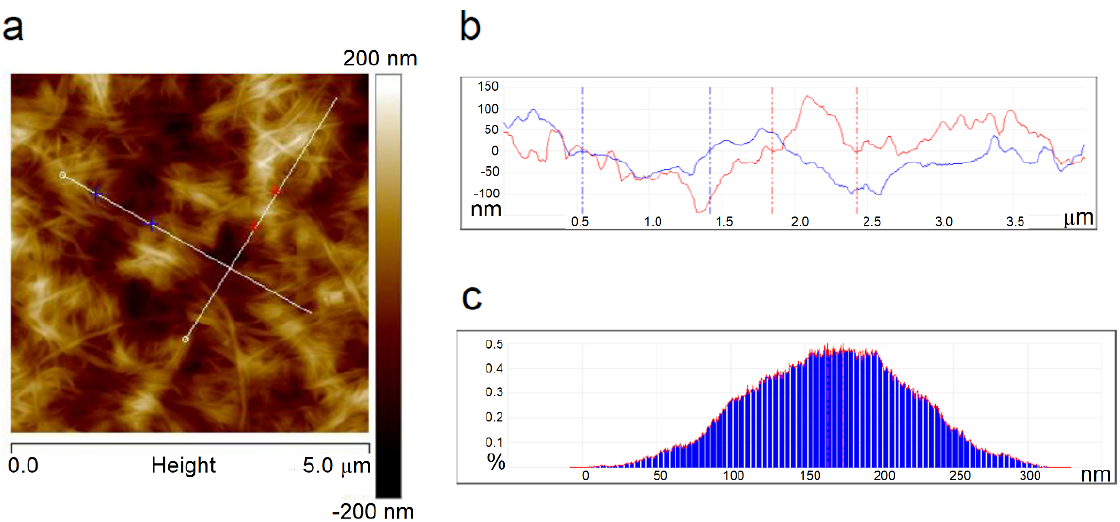
Figure 6. Two-dimensional-AFM images of BNC: height ( a , b ); cross-sections along the lines shown in Figure 6a, and depth histogram ( c ).